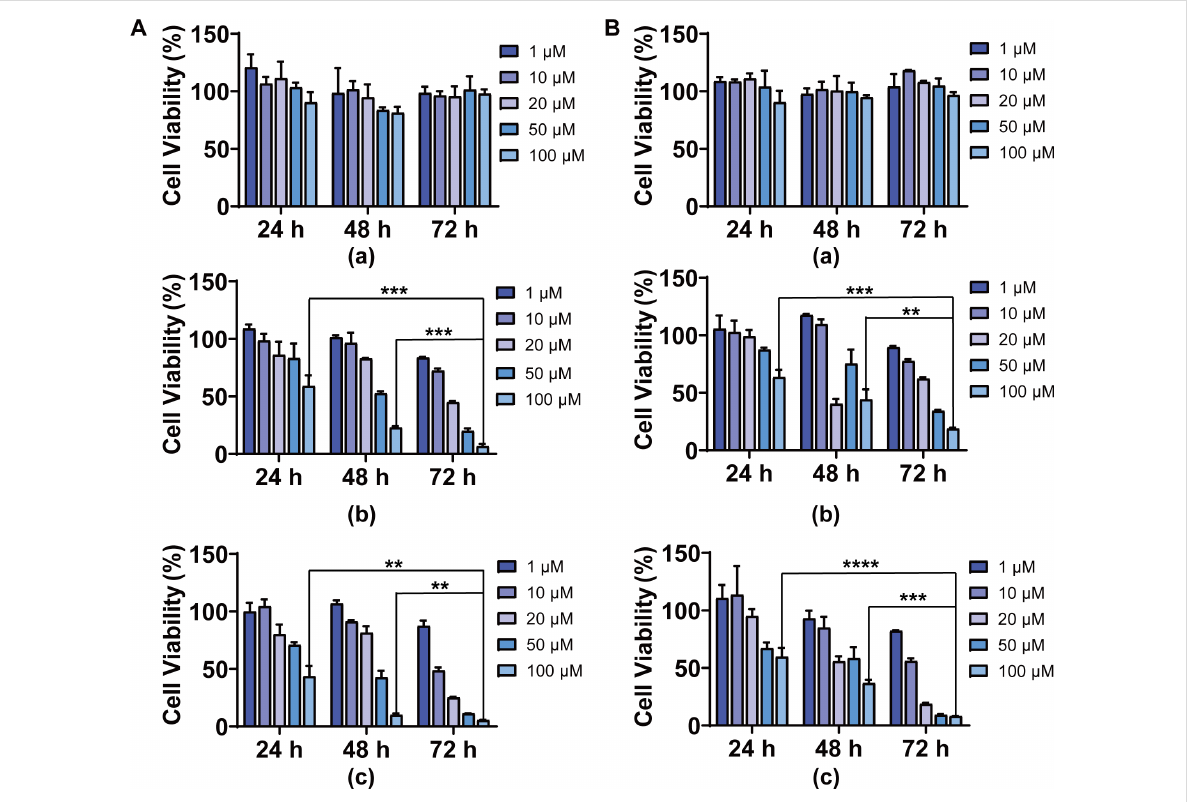
Figure 4: In vitro antiproliferative activity of blank lipid nanoparticle (P), DiP, and P2P. (A) The cytotoxicity of different concentrations of P (a), DiP (b), and P2P (c) against A549 cells for 24, 48 and 72 h. (B) The cytotoxicity of different concentrations of P (a), DiP (b), and P2P (c) against PC9 cells for 24, 48 and 72 h. ** p < 0.01 and *** p < 0.001 compared with 24 h or 48 h treatment group by Student’s t